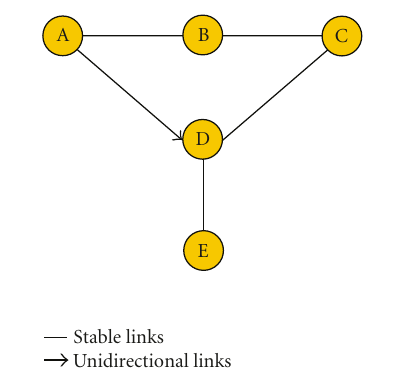
Figure 6: Network topology with unidirectional links (scenario